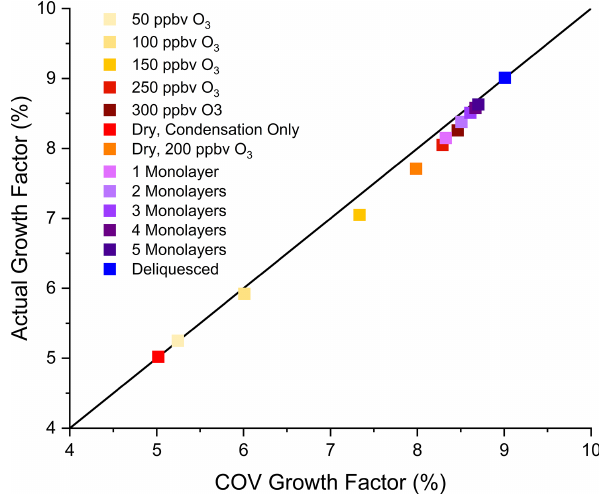
Figure 5. COV growth factor obtained from outlet-minus-inlet di- ameter change vs. actual growth factor (average of GFs within the flow tube for each simulation in Sect. 4). Colours correspond to those shown for the simulations in Figs. 3 and 4. The line shows a 1 : 1